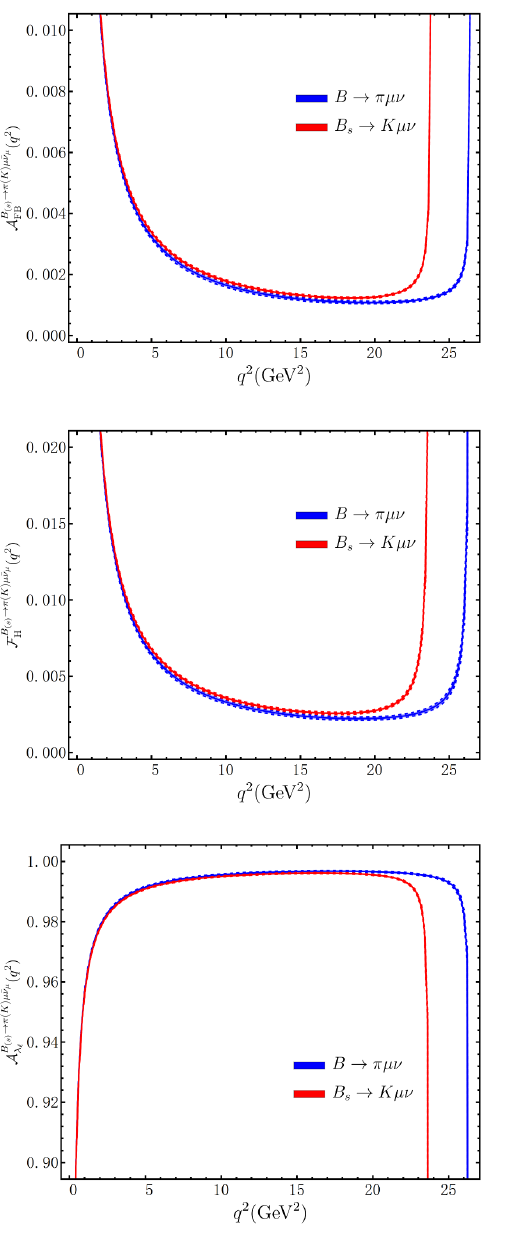
( q 2 ) obtained from the combined BCL